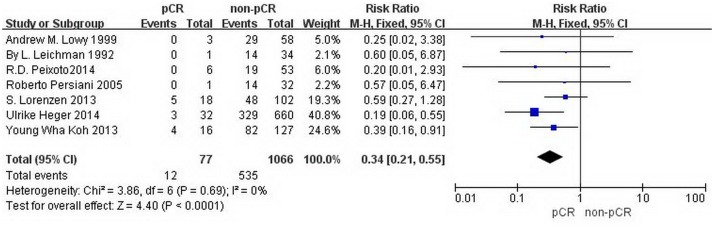
Forest plot of pooled relative risk for three-year OS from eligible studies.The area of each square represents the weighting, and the positions of each square demonstrate the risk ratio point estimate. Horizontal lines represent 95% confidence interval (CI). M-H = Mantel-Haenszel. Events = patients died from any cause within three years.